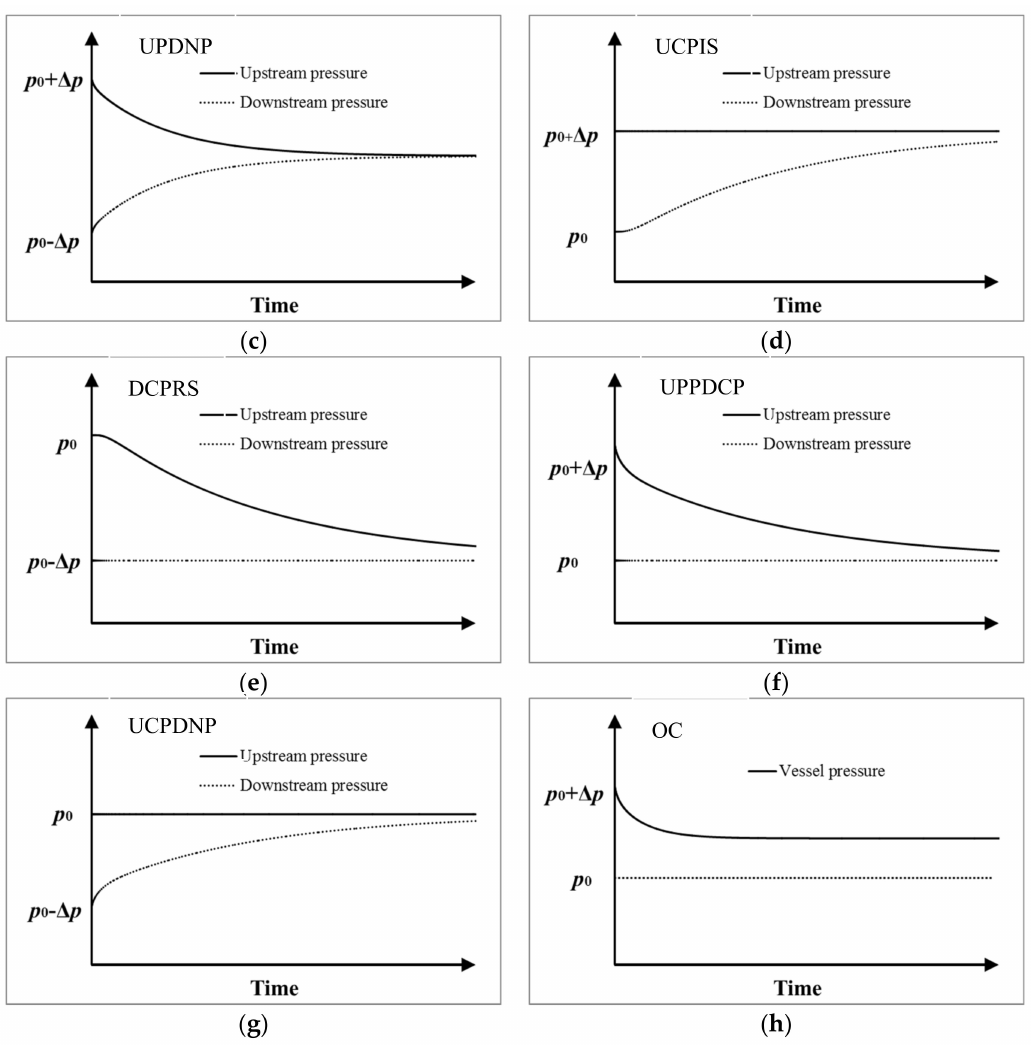
Figure 2. Schematic diagram of di ff erent test methods: ( a ) upstream positive-pulse (UPP); ( b ) downstream negative-pulse (DNP); ( c ) upstream positive- and downstream negative-pulse (UPDNP); ( d ) upstream constant-pressure increase step (UCPIS); ( e ) downstream constant-pressure reduction step (DCPRS); ( f ) upstream positive-pulse and downstream constant-pressure (UPPDCP); ( g ) upstream constant-pressure and downstream negative-pulse (UCPDNP); ( h ) one-chamber (OC). ( p 0 is the initial equilibrium pressure, and ∆ p is the pressure pulse applied in the upstream or downstream